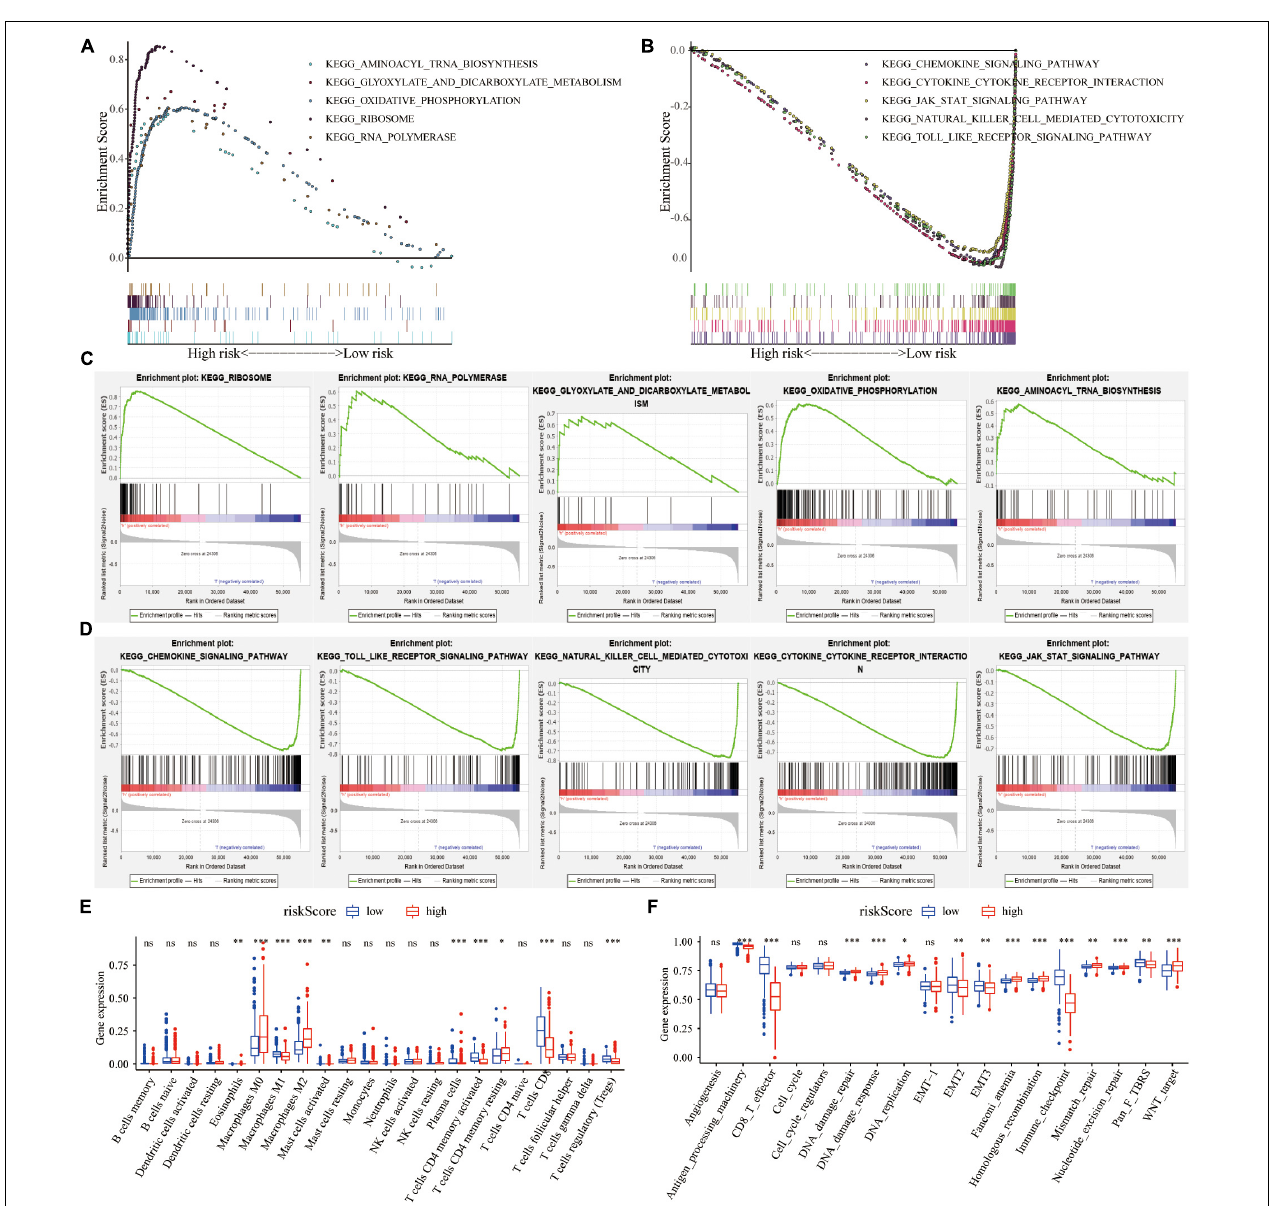
FIGURE 6 | The regulation of risk score on tumor gene expression and biological processes. (A,B) GSEA revealed the most significant hallmarks with high- and low-risk clusters. (C,D) Enrichment of representative pathways between high- and low-risk patients in GSEA analysis. (E) TIICs in the high- and low-risk groups. (F) The enrichment of different pathway characteristics (immune-related characteristics, mismatch-related characteristics, and matrix-related characteristics) in high- and low-risk patients ( ∗ p < 0.05, ∗∗ p < 0.01, ∗∗∗ p < 0.001).